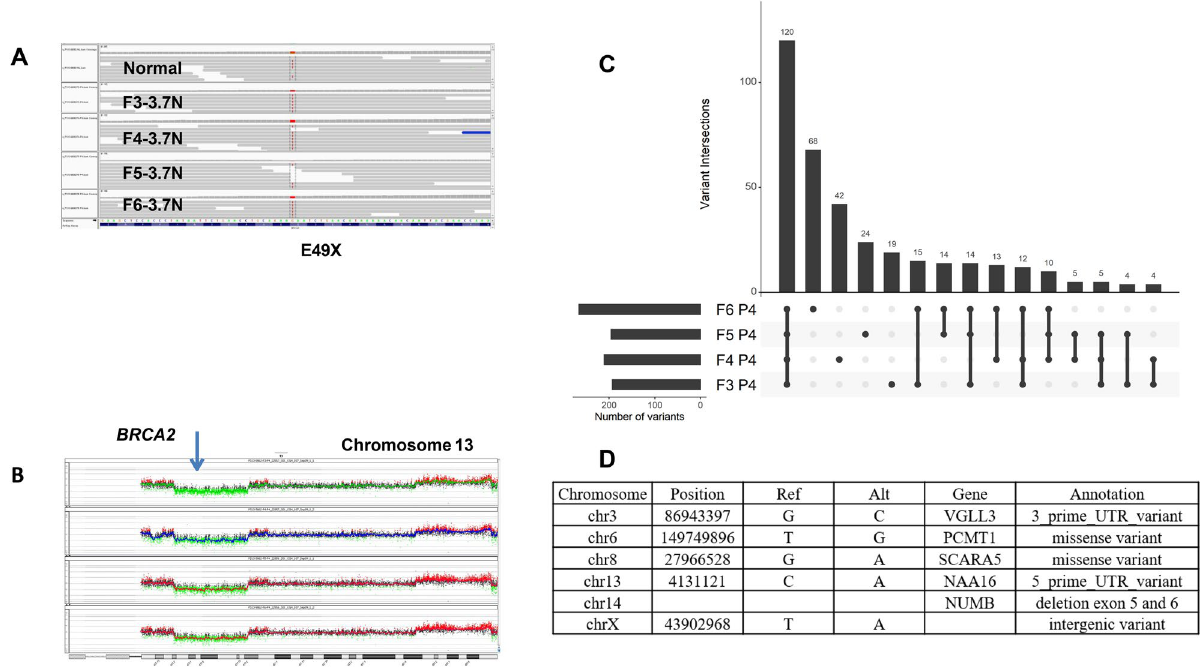
Figure 1. Genomic analysis of BRCA2 mutant germ line carrier PS13-9062. ( A ) IGV view of BRCA2 in normal and 3.7 N populations flow sorted from biopsies F3–F6. ( B ) Chromosome 13 CNV plots for biopsies F3–F6. Blue arrow denotes BRCA2 locus that maps to interstitial deletion of 13q12.3–q14.2 in each 3.7 N population. ( C ) Upset plot displaying patterns of variant sharing among samples in flow sorted biopsies. ( D ) Shared fixed somatic variants within the